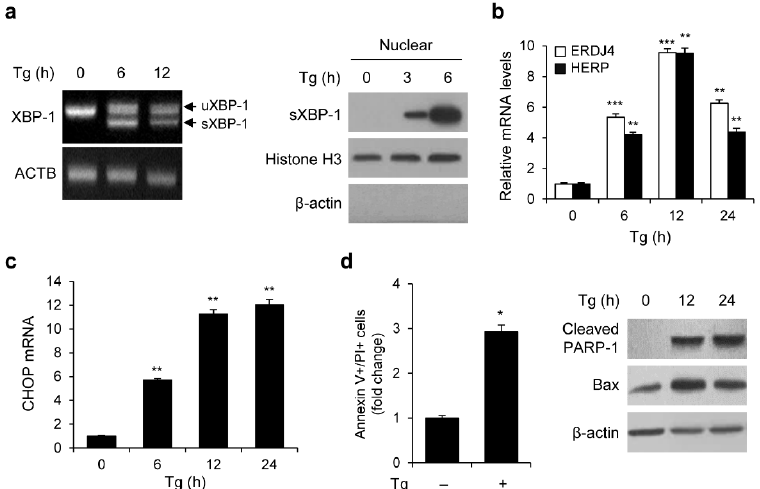
Figure 1. ER stress induces UPR activation, CHOP pathway, and apoptosis. ( a ) RT-PCR of s XBP-1 and u XBP-1 in HEK293 cells treated with 300 nM Tg at indicated times. Proteins in nuclear fractions were analyzed by Western blotting (WB). ( b , c ) The mRNA expression levels of ERDJ4 and HERP ( b ) or CHOP ( c ) were analyzed using qRT-PCR. ( d ) Apoptosis assay was performed after HEK293 cells were treated with 300 nM Tg for 24 h. Quantification of annexin V/PI positive cells was expressed as fold change compared to control cells. The protein levels of cleaved PARP ‐ 1 and Bax were analyzed using WB. (* p < 0.05, ** p < 0.01 and *** p < 0.001).